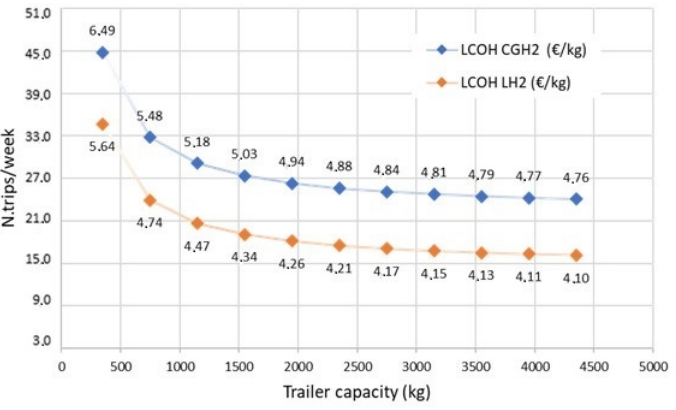
Figure 3. LCOH sensitivity analysis for the delivery of hydrogen, varying the trailer capacity (kg) and the number of trips required to supply the demand (trips/week).